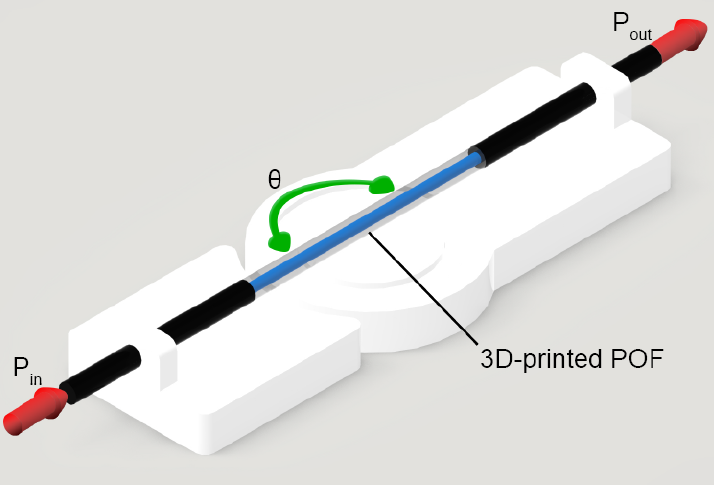
Figure 1. The setup used to measure the change in the intensity of the laser beam with the variation of the angle θ